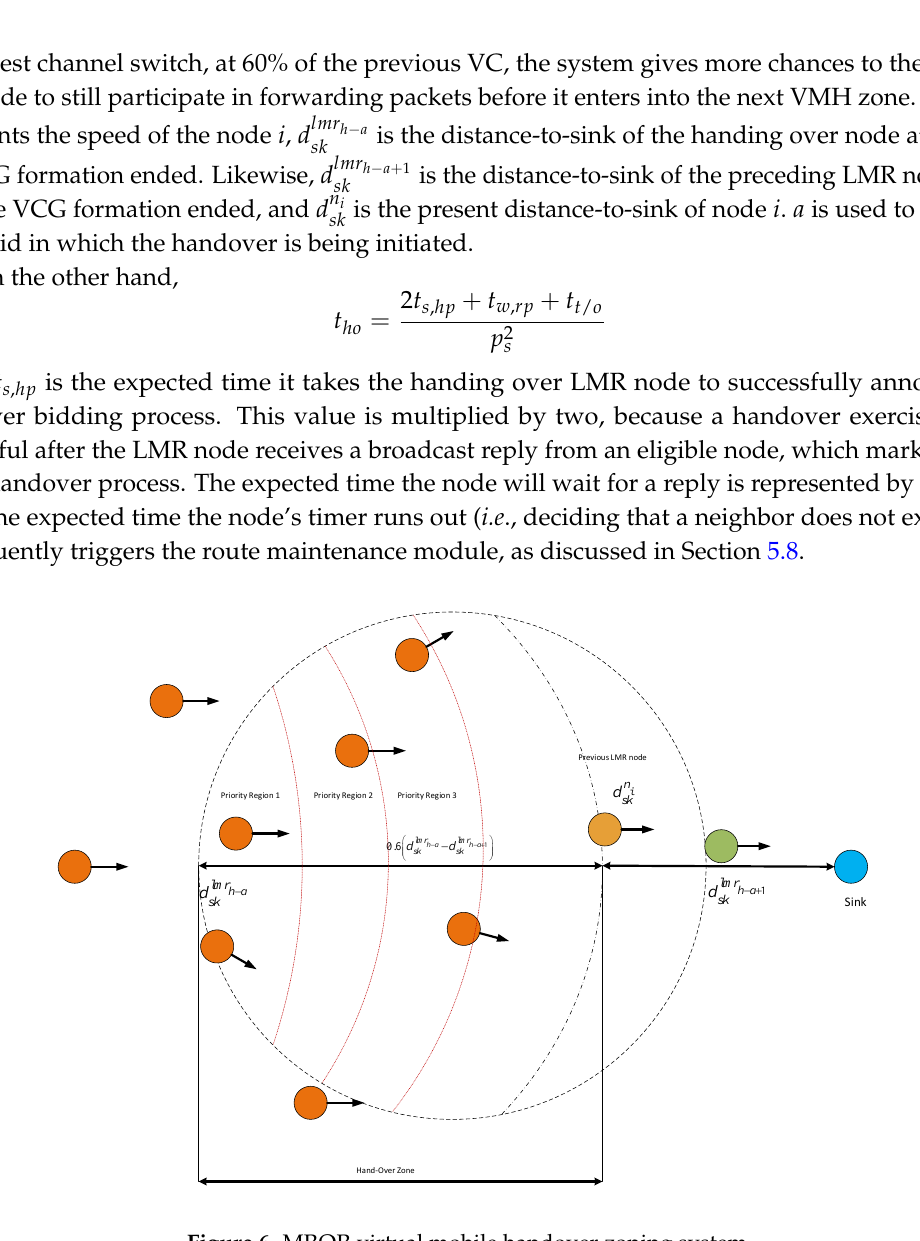
Figure 6. MROR virtual mobile handover zoning